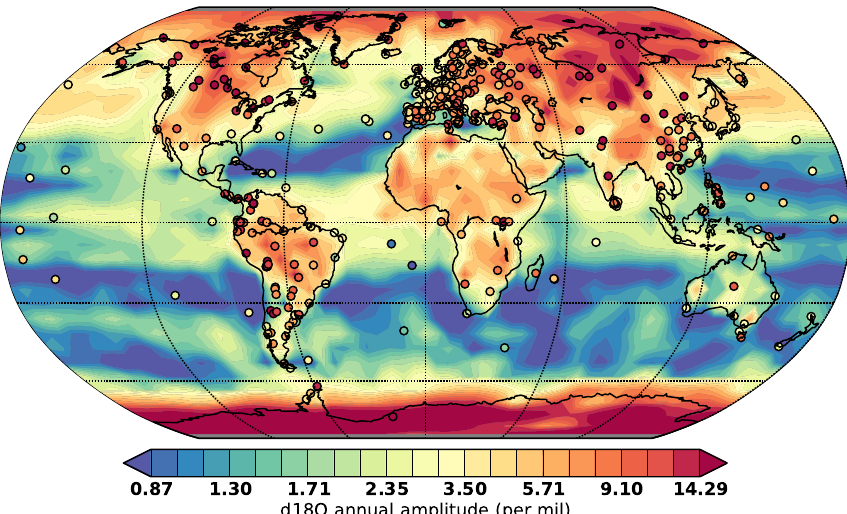
Fig. 4. Annual δ 18 O amplitude in precipitation in i LOVECLIM computed from monthly mean climatology. The amplitude is calculated as: (cid:16) (cid:17) (cid:16) (cid:17) − minimum ; m = 1 , 12 where m stands for the months of the year. Datapoints are from 1δ 18 O = maximum δ 18 O (m),m δ 18 O (m),m the GNIP dataset (IAEA,